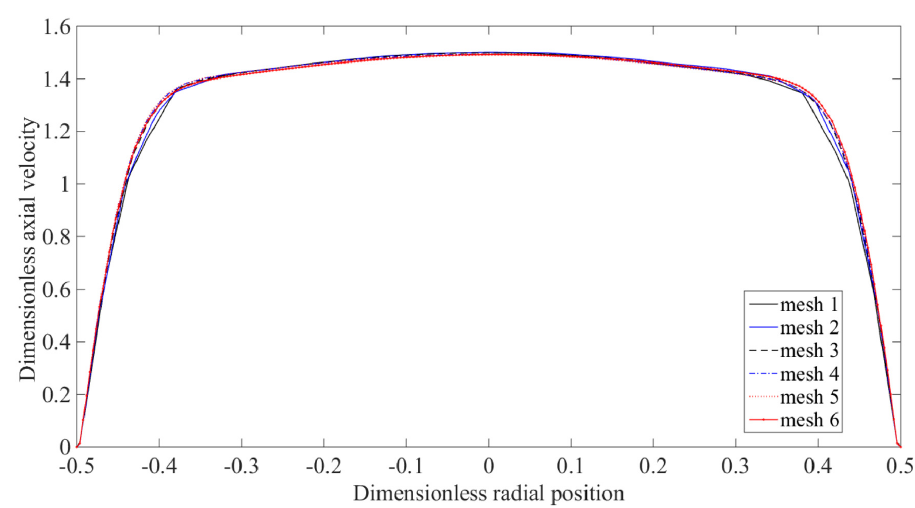
Fig 2. The dimensionless axial velocity, u at the centre of the stenosis, x = 0 for mesh 1 = 3516, mesh 2 = 7684, mesh 3 = 11780, mesh 4 = 17322, mesh 5 = 23346 and mesh 6 = 25108.